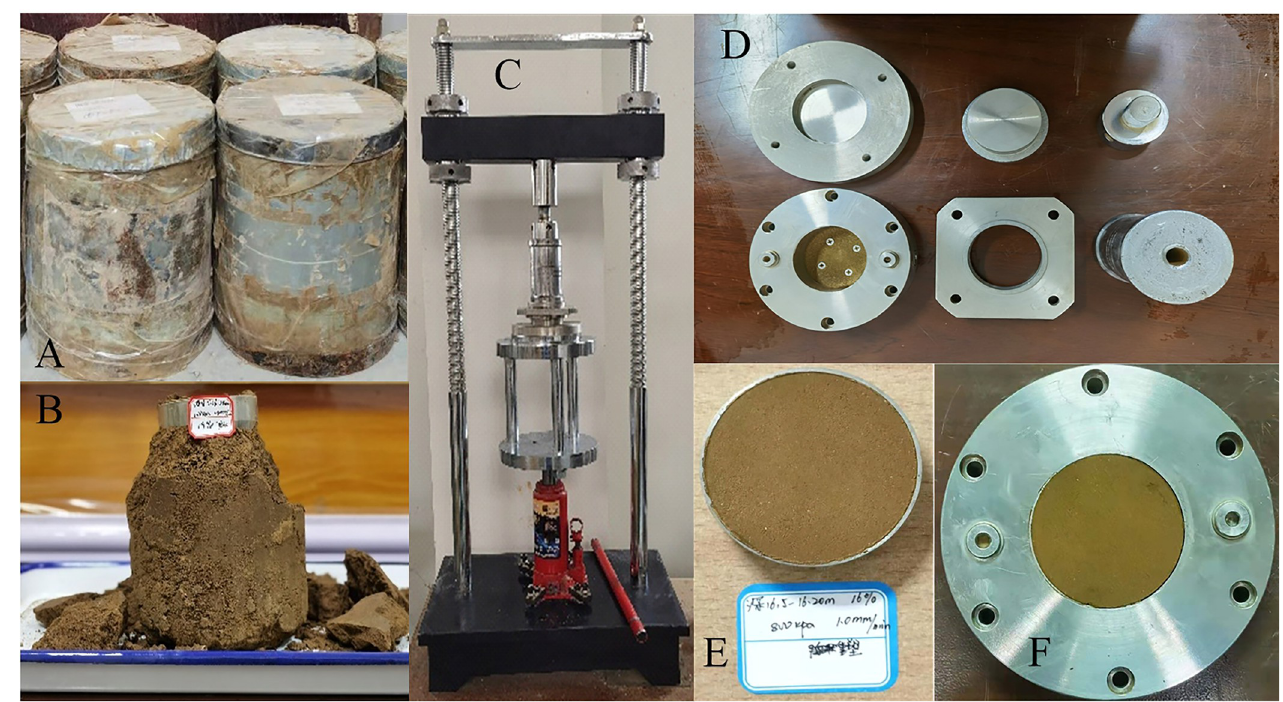
Fig 1. Sampling equipments and methods for undisturbed and remolded loess. (A) Undisturbed loess specimen sealed in iron cylinder. (B) Preparation of undisturbed loess cutting ring specimen. (C) Remodeling specimen preparation equipment. (D) Reshaping specimen preparation tool. (E) Remodeling cutting ring specimen. (F) The remolded cutting ring specimen into the shear box.